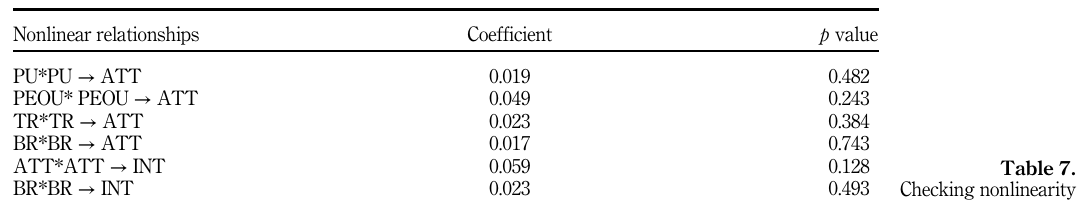
Table 6. Specific indirect effect